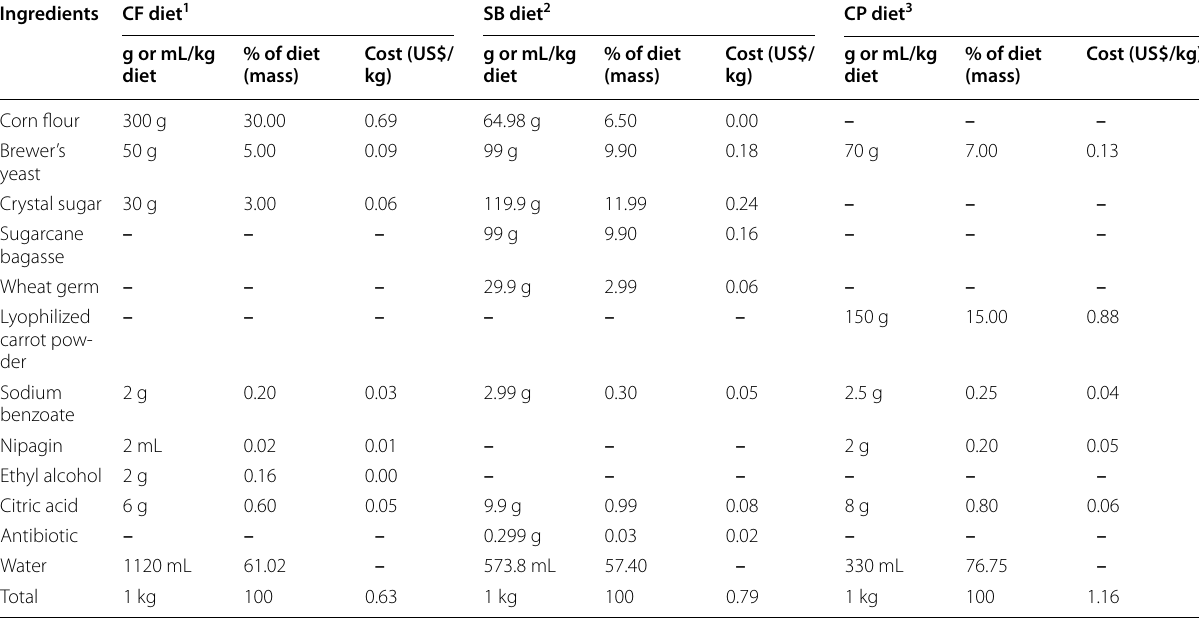
Table 1 Composition and cost of 1 kg of the three tested larval diets for Ceratitis